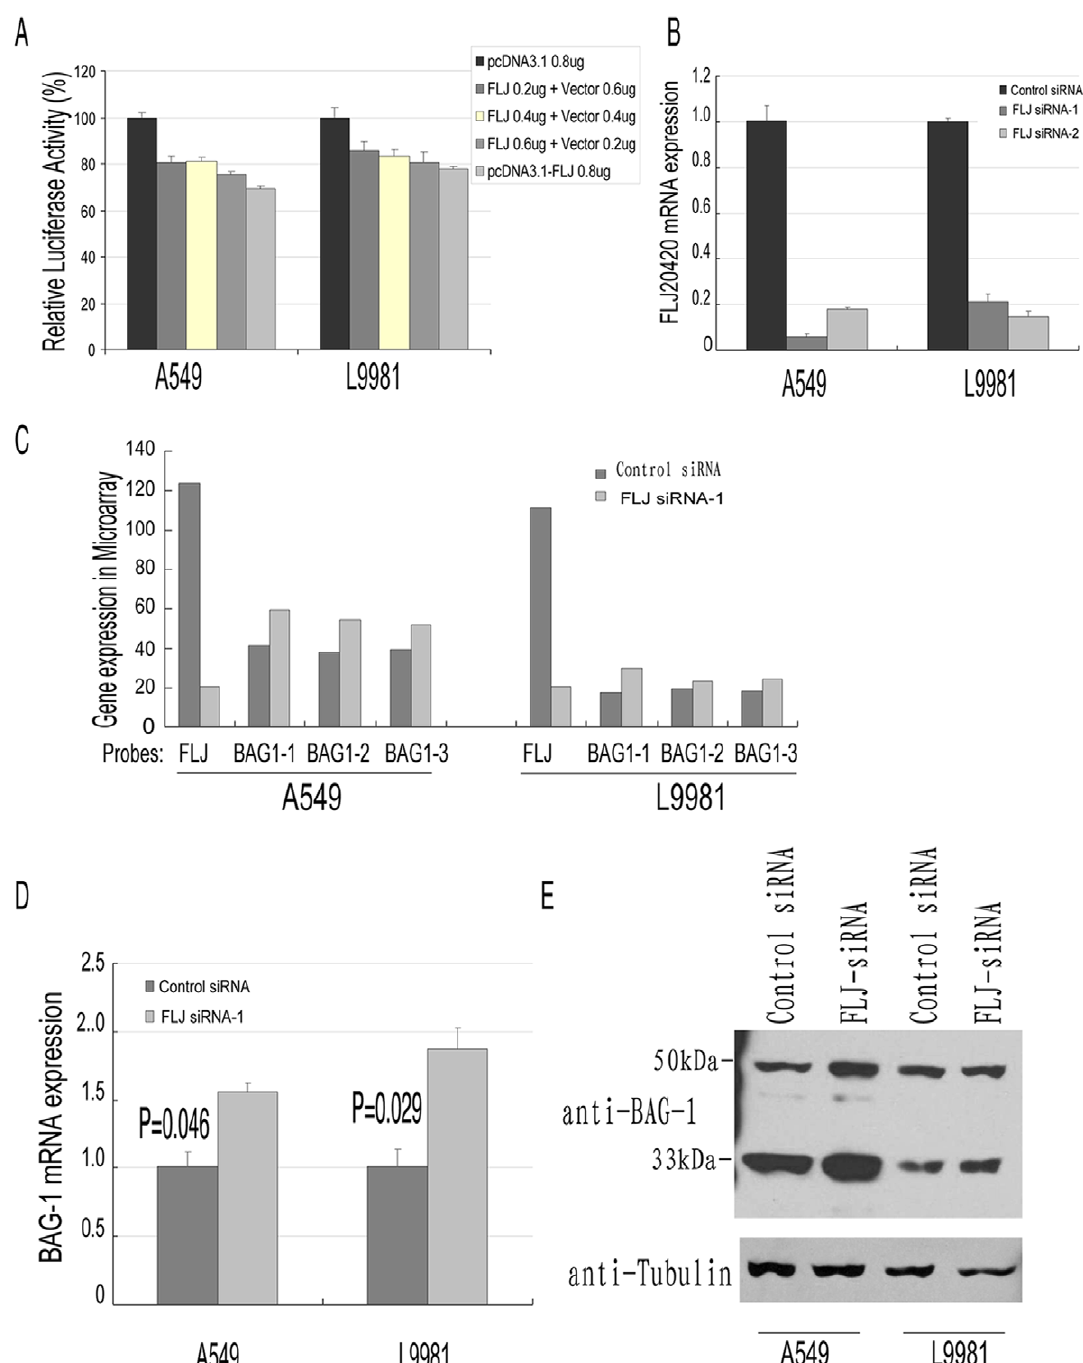
Figure 3. FLJ20420 down-regulates the expression of BAG-1 in lung cancer cell lines. (A) Luciferase assay with BAG-1 promoter. Luciferase reporter under the control of the BAG-1 promoter was co-transfected in A549 and L9981 cells with either the pcDNA3.1 parent vector or pcDNA3.1- FLJ20420 expression plasmid. Luciferase activity for the BAG-1 promoter is set as 100% upon transfection with the empty pcDNA3.1 vector. Transfection efficiency was determined by co-transfecting the pRL-CMV vector, which encoded the Renilla luciferase gene (0.02 m g). (B) Knockdown of FLJ20420 expression in A549 and L9981 cell lines. Cells were transfected with either FLJ20420 siRNA-1, -2 or scrambled control siRNA. After 48 h of transfection, the cells were collected and total RNA was extracted. FLJ20420 mRNA expression was measured by real-time PCR, in triplicate, as described in the methods section. (C) Microarrays of FLJ20420-silenced A549 and L9981 cells. In both of the FLJ20420-silenced A549 and L9981 cell lines, FLJ20420 expression was dramatically reduced, while BAG-1 expression increased, in comparison to control transfected cells. (D) BAG-1 mRNA expression in FLJ204200-siRNA transfected cells, as measured in triplicate by real-time PCR, and described in the methods section. (E) BAG-1 protein expression in FLJ20420-siRNA transfected cells was detected by Western blotting with anti-BAG-1 antibody at the same time points post-transfection. Tubulin was used as an internal control.